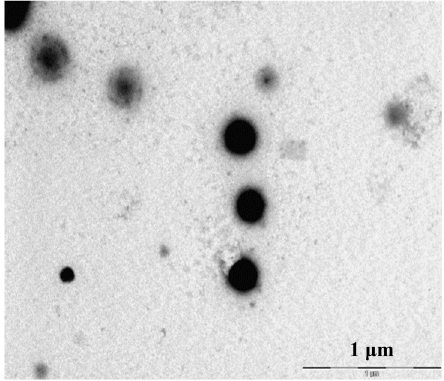
Figure 2. TEM microphotograph of representative CS/CHS nanoparticles (CS/CHS = 3/1, w/w).